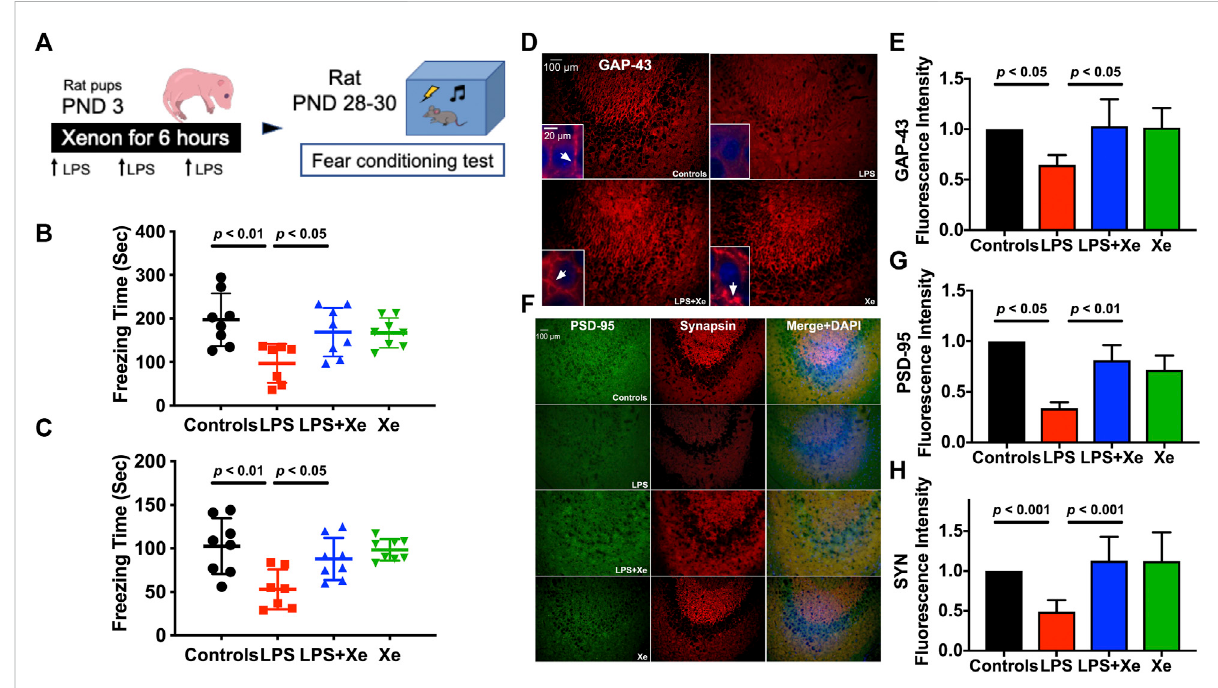
FIGURE 2 Xenon attenuated juvenile cognitive de fi cit and preserved synaptic integrity after LPS administration at neonatal stage. Study Scheme (A) . Freezing time for context test (B) and cue-tone test (C) tested 26 days and 27 days after initial LPS injection, respectively. Data are expressed as mean ± SD. ( n = 7 in group LPS and n = 8 in group Con, LPS + Xe and Xe). Representative immunohistochemistry staining (D) with quanti fi cation (E) forhippocampalexpressionofGrowthAssociatedProtein43(GAP-43)inPND30rats(27 daysafterinitialLPSinjection).Thearrowheadsinthe insets showed the accumulation of GAP-43, which is essential for functional axon growth. Representative immunohistochemistry staining (F) with quanti fi cation (G,H) forhippocampalexpressionofSynapsinandPSD-95inPND30rats(27 daysafterinitialLPSinjection),themarkersforfunctional presynapticterminals and excitatory postsynaptic membranes respectively. Data are expressed as mean ± SD and n = 4 in each group. (Con = saline injection + 70%N 2 /30%O 2 ; LPS = LPS injection + 70%N 2 /30%O 2 ; LPS + Xe = LPS inhalation + 70%Xenon/30%O 2 ; Xe = saline injection + 70% Xe/ 30% O 2